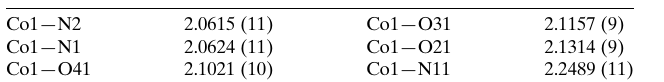
Table 2 Selected bond lengths (A˚ ) for 2 .